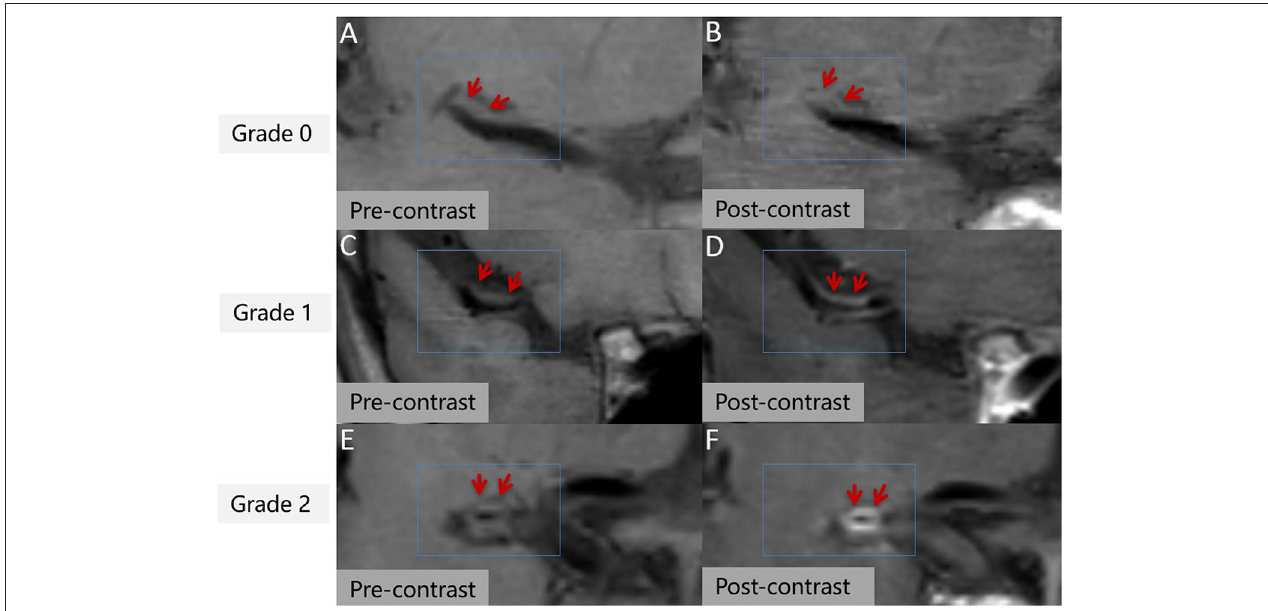
FIGURE 2 | Intracranial plaque enhancement at different levels pre- (A,C,E) and post-contrast (B,D,F) . 3D T 1 volume isotropic turbo spin-echo acquisition (T1 VISTA) image showing eccentric atherosclerotic plaques (red arrow). Grade 0 enhancement (B) , grade 1 enhancement (D) , grade 2 enhancement (F) .